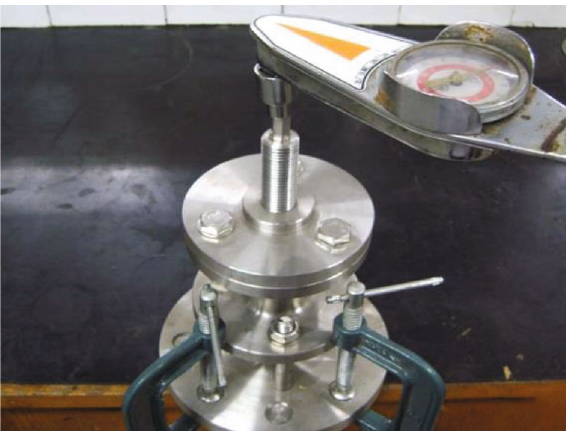
Figure 3: Picture of bulk hardness tester.